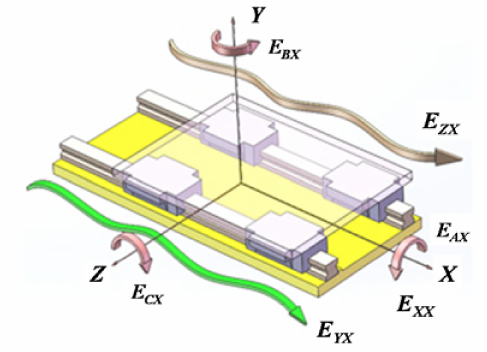
Figure 1. 6-DOF geometric errors of a linear moving